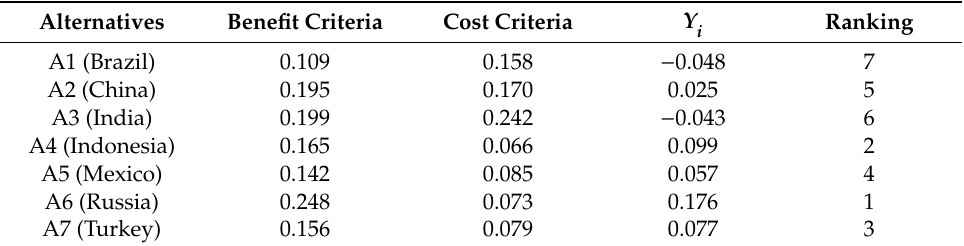
Table 12. Benefit and cost values and ranking the E7 economies for universal health coverage.